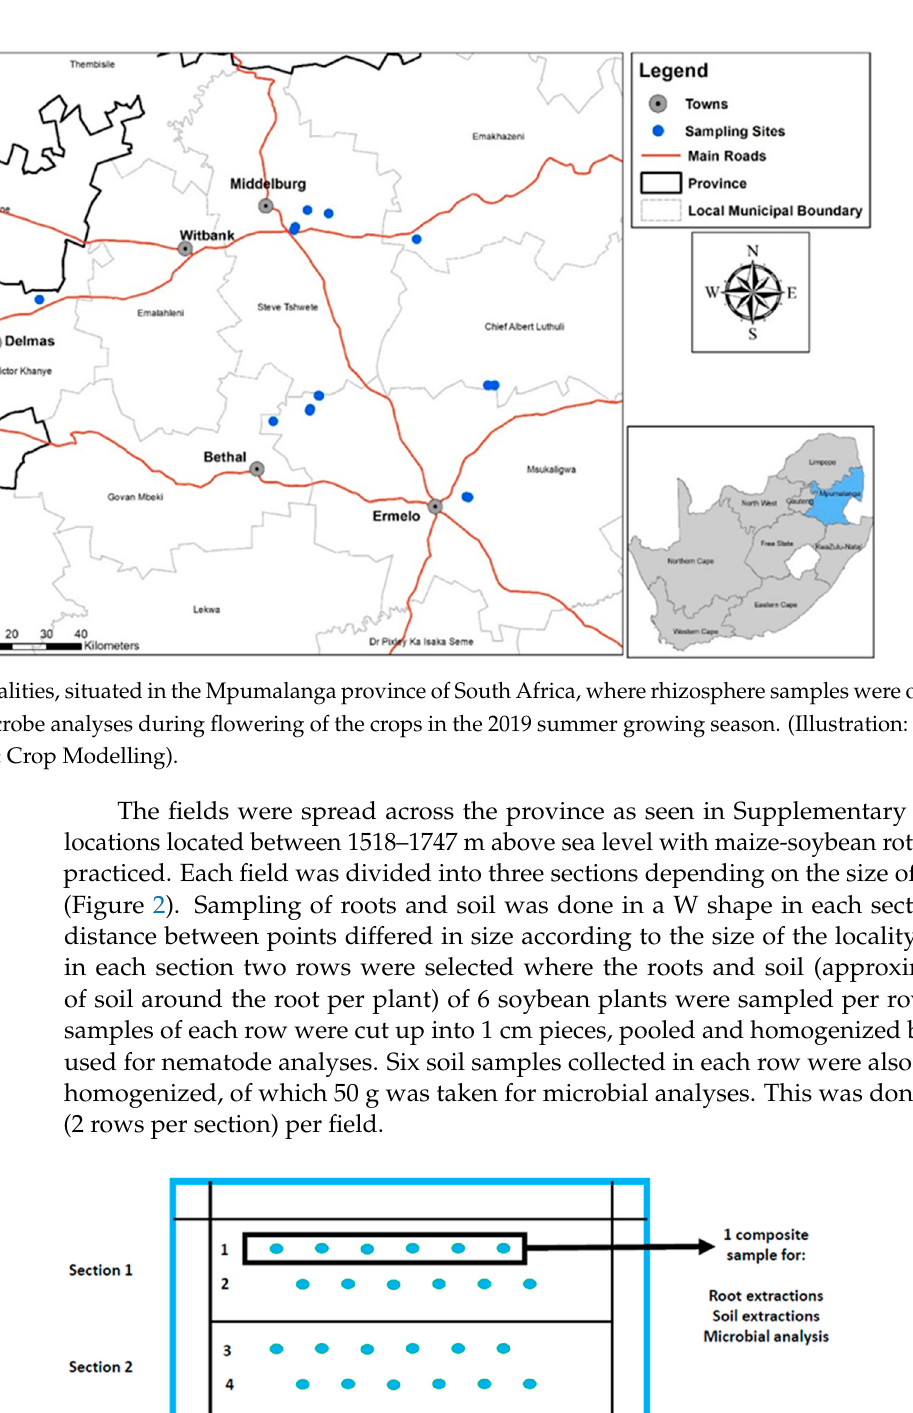
Figure 2. Sampling strategy at each of the 15 soybean localities sampled during the 2019 growing season for nematode and microbe analyses (Illustration: Gerhard Engelbrecht, North-West Univer- sity). Each field therefore had a total of 6 composite root and soil samples that were analyzed.